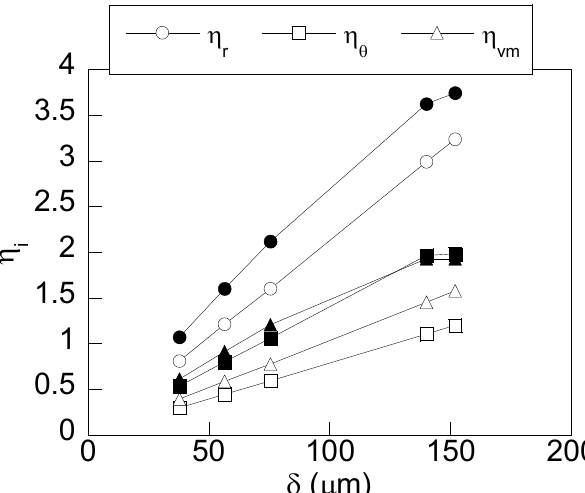
Figure 14. Variation of the parameter η radial, tangential, and von Mises as a function of the radial interference (blank symbols, γ = 0.125 and full symbols, γ = 0.250).